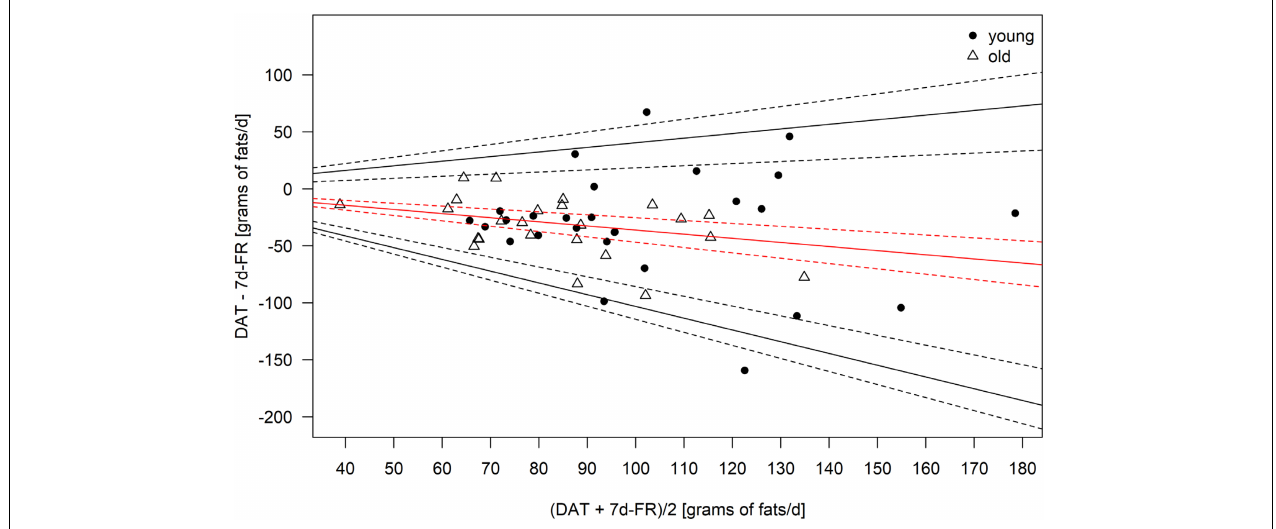
FIGURE 4 | Bland–Altman Plot of the fat intake as calculated from the 7 d-FR and the visually aided DAT. Legend: Red solid line, mean; black solid lines, 95% limits of agreement; dotted lines, 95% of the respective solid lines.